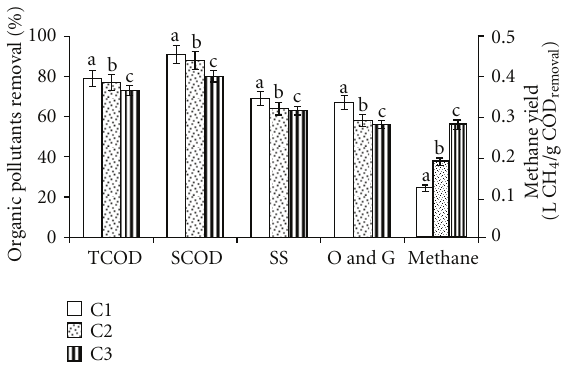
Figure 2: Overall process performances in organic pollutants removal and methane